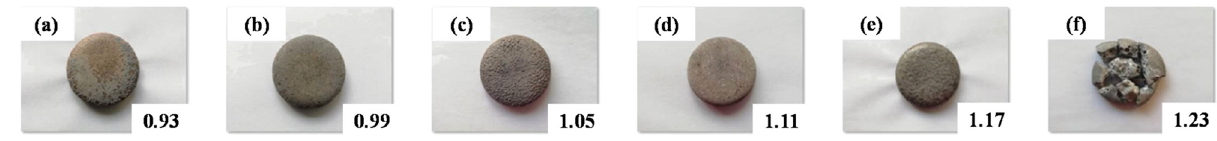
Figure 4: Morphology of slag with di ff erent binary basicity after reaction. ( a ) R = 0.93; ( b ) R = 0.99; ( c ) R = 1.05; ( d ) R = 1.11; ( e ) R = 1.17; ( f ) R =